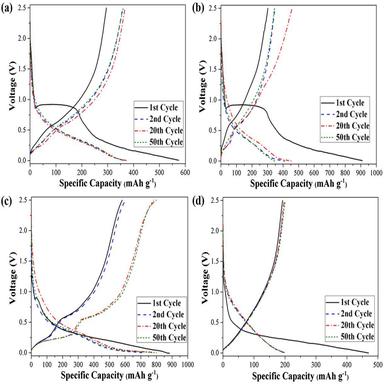
Galvanostatic charge-discharge profiles of SnSb@CMFs-1 (a), SnSb@CMFs-2 (b), SnSb@CMF-2@C (c), and CMFs (d) at a current density of 100 mA∙g1 .